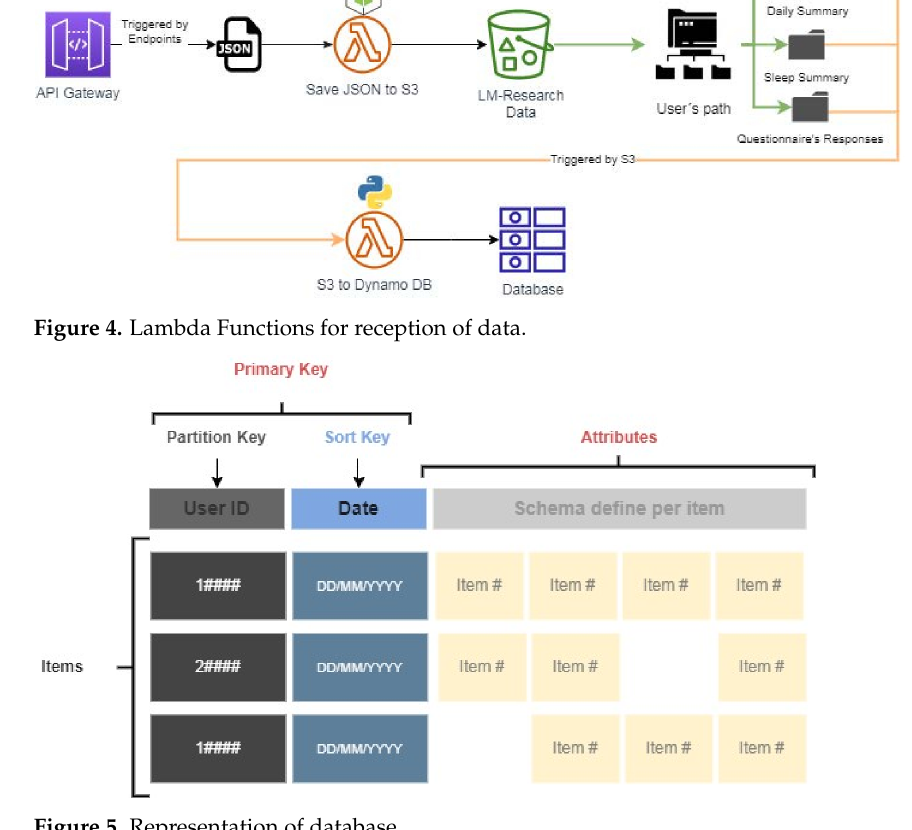
Figure 5. Representation of